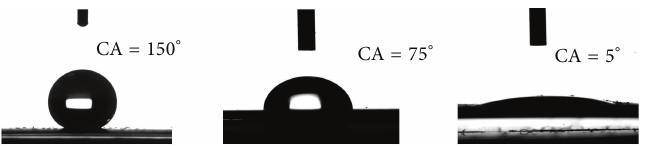
Figure 3: Aluminum surfaces of different